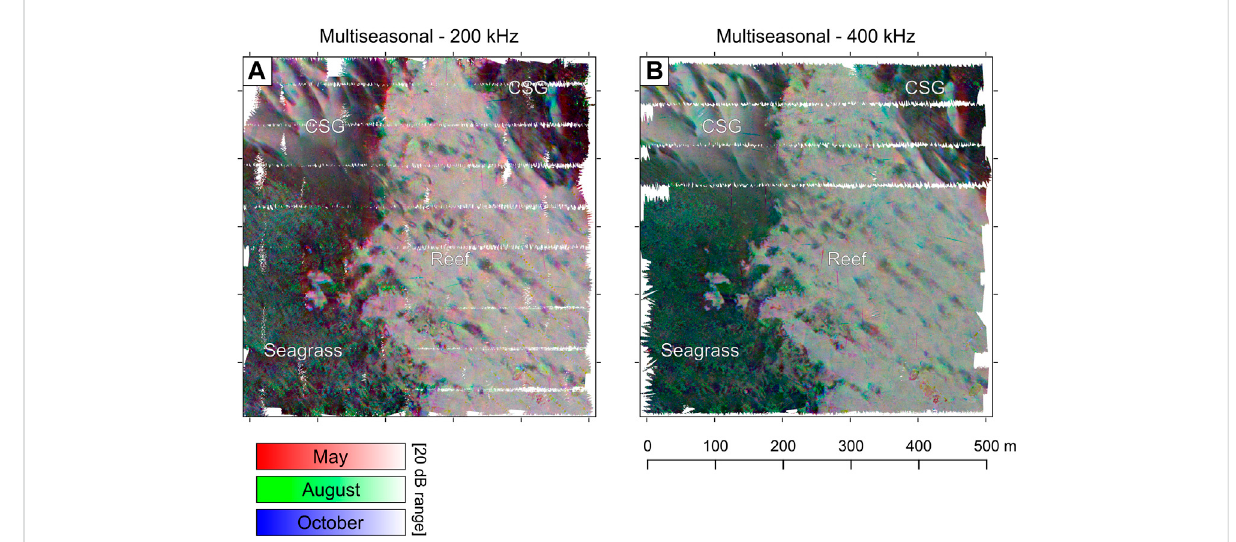
FIGURE 6 Multiseasonal backscatter maps, where the RGB channels of the false-color images are assigned to the backscatter maps of the month May, August, and October, respectively. (A) 200 kHz frequency. The CSG facies is characterized by the change of dark colors, indicating generally low- backscatter values, and brighter stripes, which vary in color, assumed to be caused by hydrodynamically induced shifts in sediment composition. In addition to the low-backscatter stripes, the reef facies appears in a bright reddish color, indicating generally high-backscatter values with a maximum in May. The seagrass facies is dominated by the cloudy seagrass patches in green – turquoise colors based on high-backscatter values in August and October. (B) 400 kHz frequency. The reef facies appears in a bright greyish color, representing only small differences between the months compared to 200